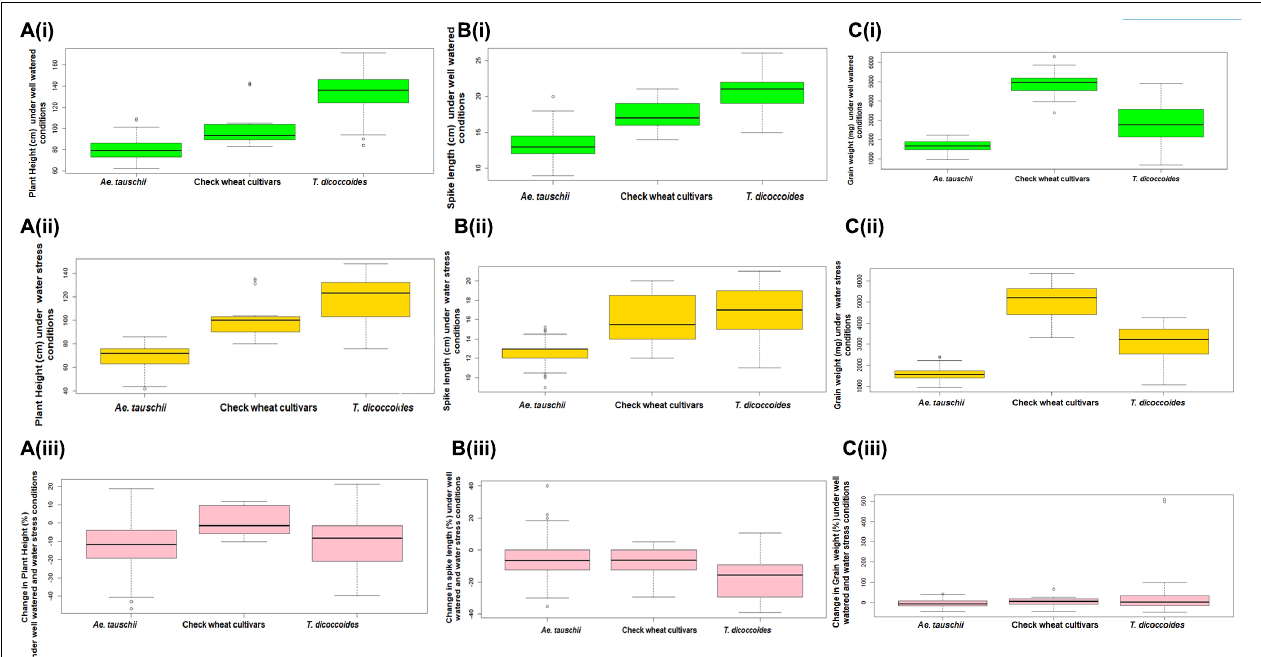
FIGURE 8 | Boxplots representation of phenotypic traits of accessions of Ae. tauschii , T. dicoccoides and check wheat cultivars under well watered and water stress conditions. (A) Plant height under (Ai) well watered, (Aii) water stress, and (Aiii) change in plant height under well watered and water stress conditions. (B) Spike length under (Bi) well watered, (Bii) water stress, and (Biii) change in spike length under well watered and water stress conditions. (C) Grain weight under (Ci) well watered, (Cii) water stress, and (Ciii) change in grain weight under well watered and water stress conditions.